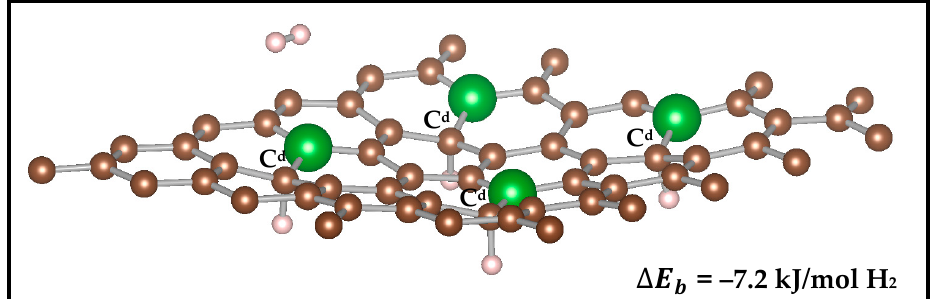
Figure 2. Binding energy ( ∆𝐸 (cid:3029) ) of H 2 on periodic graphene and different boron – doped concentrations with interlayer spacing of 15 Å along z –axis. Both 2% and 7% B-doping (middle and bottom panel, respectively) show the H 2 interacting near the C d atom. The second monolayer at 15 Å along z –axis is not shown here for simplicity. The side and top views are shown in Figure S4 in the Supplementary Materials.